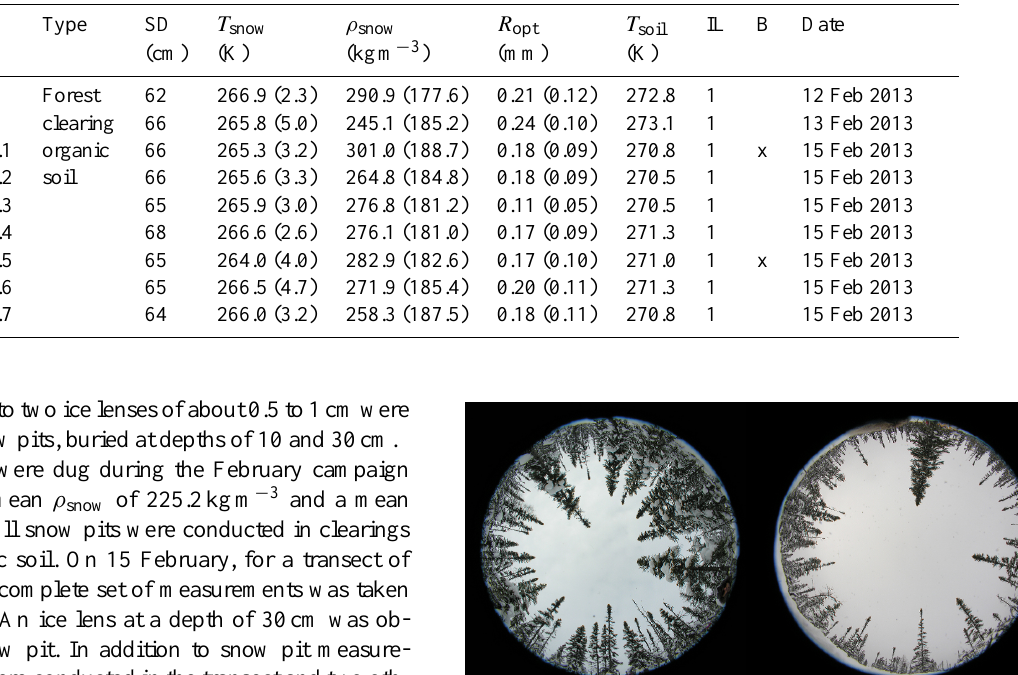
Table 2. Same as Table 1 but for James Bay sites in February (JB Feb ) .